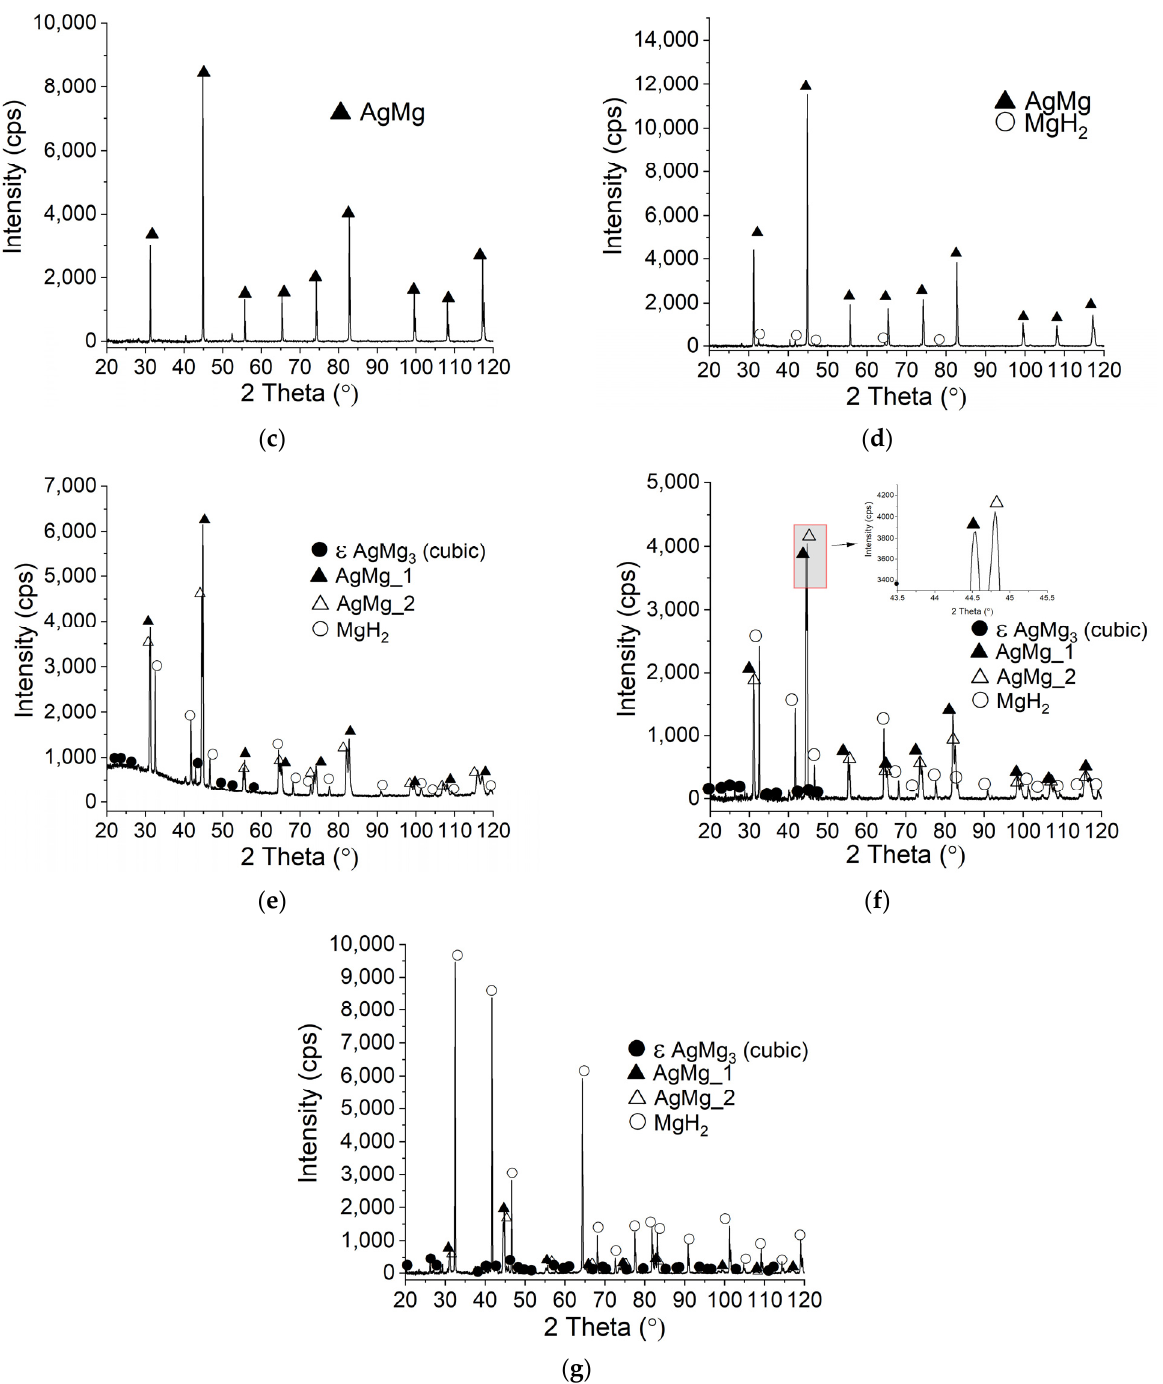
Figure 8. X-ray diffraction patterns for Ag-Mg samples after the hydrogenation process: ( a ) Alloy 10, ( b ) Alloy 9, ( c ) Alloy 8, ( d ) Alloy 7, ( e ) Alloy 6, ( f ) Alloy 5, and ( g ) Alloy 2. Structural studies show that the samples containing 5 wt. %, 10 wt. %, 15 wt. %, and